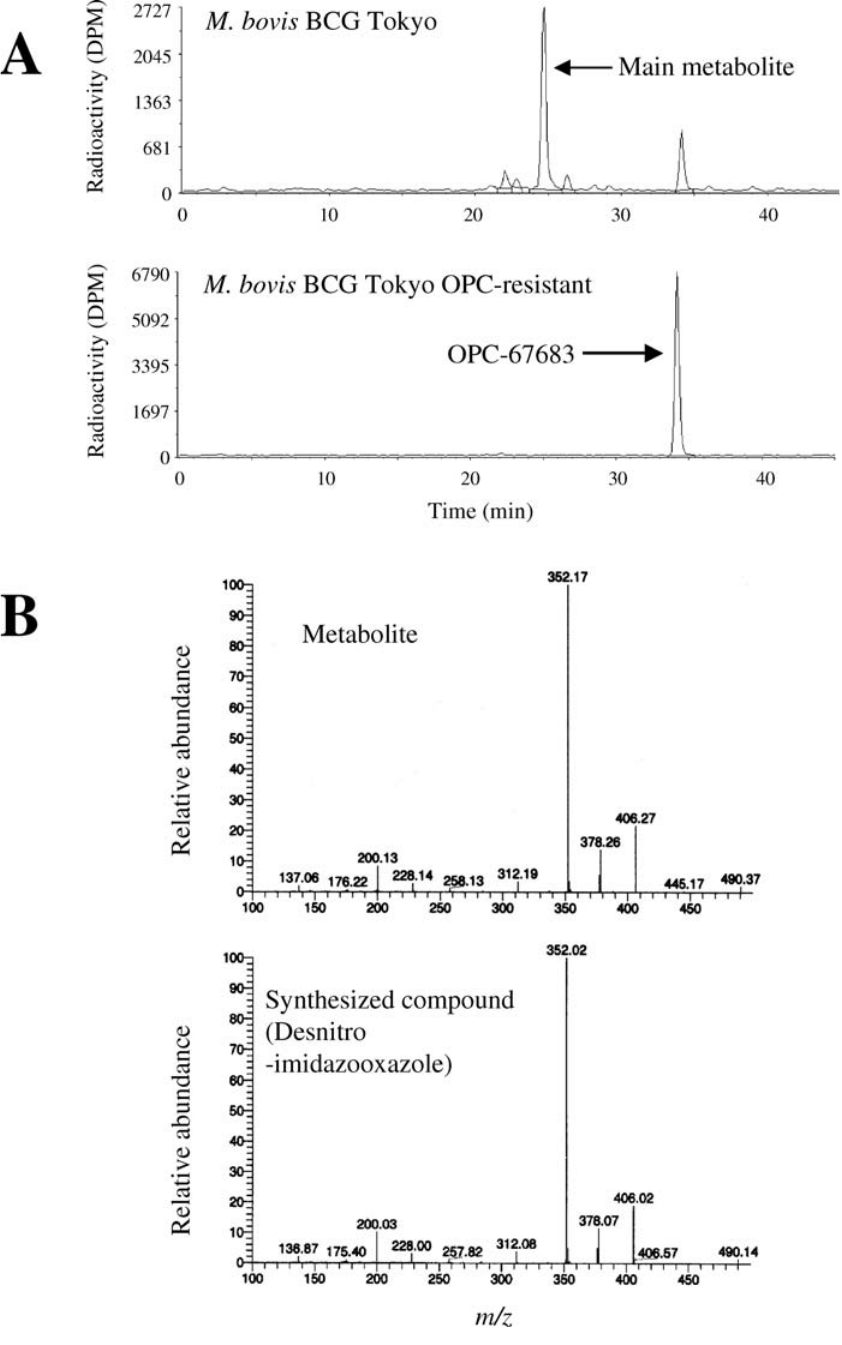
Figure 2. Analysis of Metabolites Produced after Mixing OPC-67683 and M. bovis BCG (A) 15 l l of 14 C OPC-67683 (0.5mg/ml: 0.056 l Ci/ l l) was added to 585 l l of 7H9/TN-ADC broth or bacterial culture and incubated for 48 h. After incubation, a 2-fold volume of acetonitrile was added and mixed well. The lysate was centrifuged for 5 min at 15,000 rpm. The supernatant